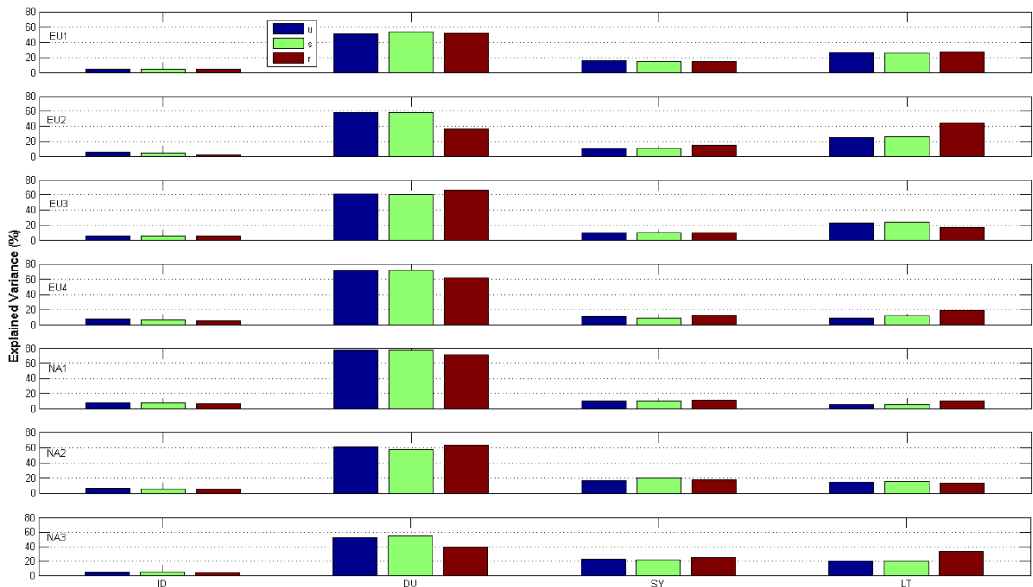
Fig. 6. The explained variance from the four (ID, DU, SY, LT) spectral components (single contributions+interactions) for the observation time series, for all seven subdomains and three ozone aggregation